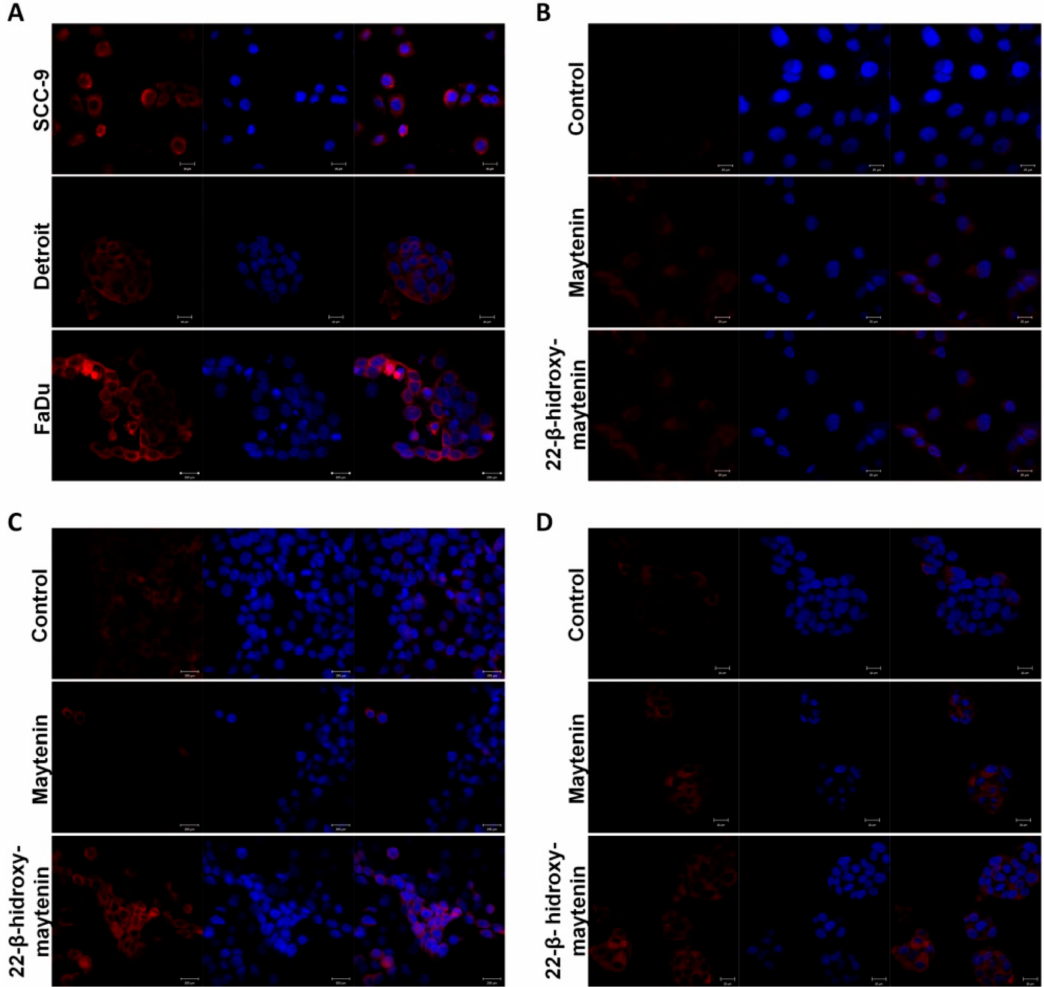
Figure 5. E ff ect of triterpenes on oxidative stress in SCC cell lines. ( A ) SCC9, Detroit and FaDu cell lines treated with cisplatin. ROS induction following cisplatin treatment is well established and these results were used as positive controls. The oxidative stress increases in tumor cells, compared with control when treated with maytenin or 22- β -hydroxymaytenin in SCC9 ( B ), FaDu ( C ) and Detroit ( D ). Total ROS after treatment with the IC 50 value for 18 h was assessed by fluorescent probe detection using confocal microscopy. n =